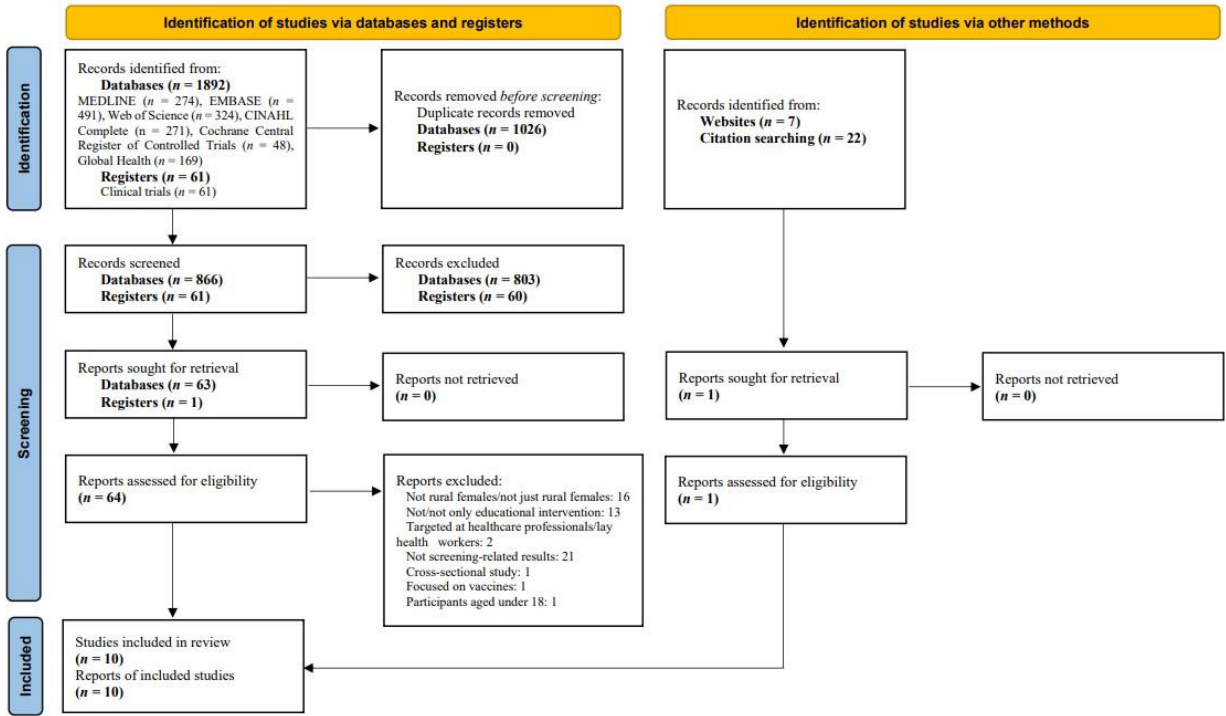
Figure 1. PRISMA flow diagram.